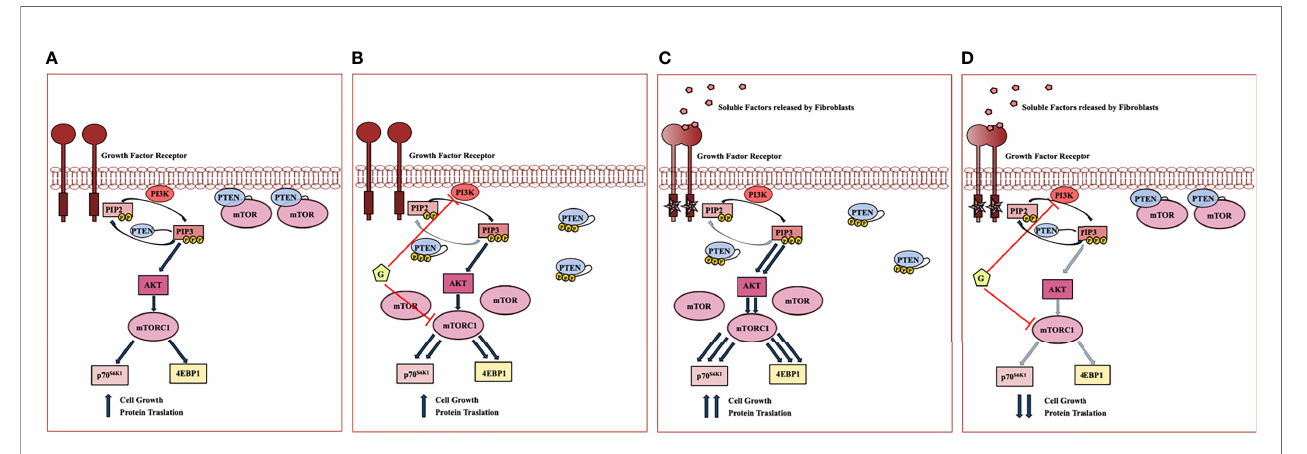
FIGURE 6 | Working model of fi broblast mediated PI3K pathway hyperactivation and response to double PI3K/mTOR inhibitors in PTEN-competent CRC cell lines. (A) In serum-free condition of growth, PTEN is associated to plasma membrane and co-localizes with mTOR, acting as a negative regulator of PI3K signaling at different levels. (B) Despite PI3K inhibition, Geda (G) causes PTEN C-terminal tail phosphorylation and cytoplasmic redistribution, accompanied by loss of co-localization with mTOR at the plasma membrane, presumably by interrupting a negative feedback loop; the net result of double PI3K/mTOR inhibition, in this context, is paradoxical pathway (re)activation, whereby Geda induces its own resistance mechanism(s). (C) Upon fi broblast-CM exposure, two main molecular events concurrently occur with the PTEN C-terminal tail phosphorylation and redistribution within the cells: I) PTEN loses its negative control on PIP3 phosphorylation; II) PTEN no longer co-localizes with mTOR at the plasma membrane, thus rendering mTOR more available to form functionally active complexes and causing mTORC1 and downstream pathway hyperactivation. (D) Under conditions in which fi broblast-CM drives PTEN-dependent PI3K/mTOR paradoxical activation, double PI3K/mTOR inhibition strongly switches off signaling through the PI3K cascade, thereby restoring Geda-mediated growth